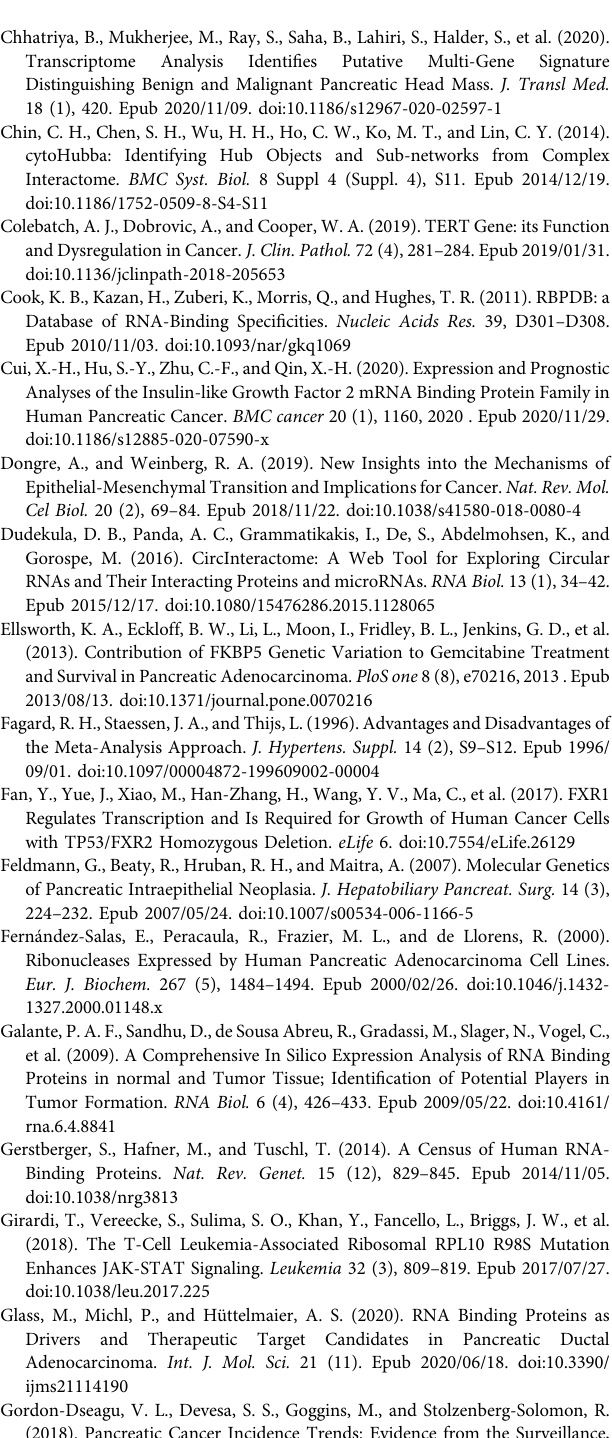
TARGET KEGG ” , and results of downregulated coding targets are shown in sheet 3 named as “ DOWN TARGET KEGG. ” Supplementary Table S8 | List of published reports of experimental validation verifying the expression status of altered RBPs in pancreatic cancer cell lines and patient